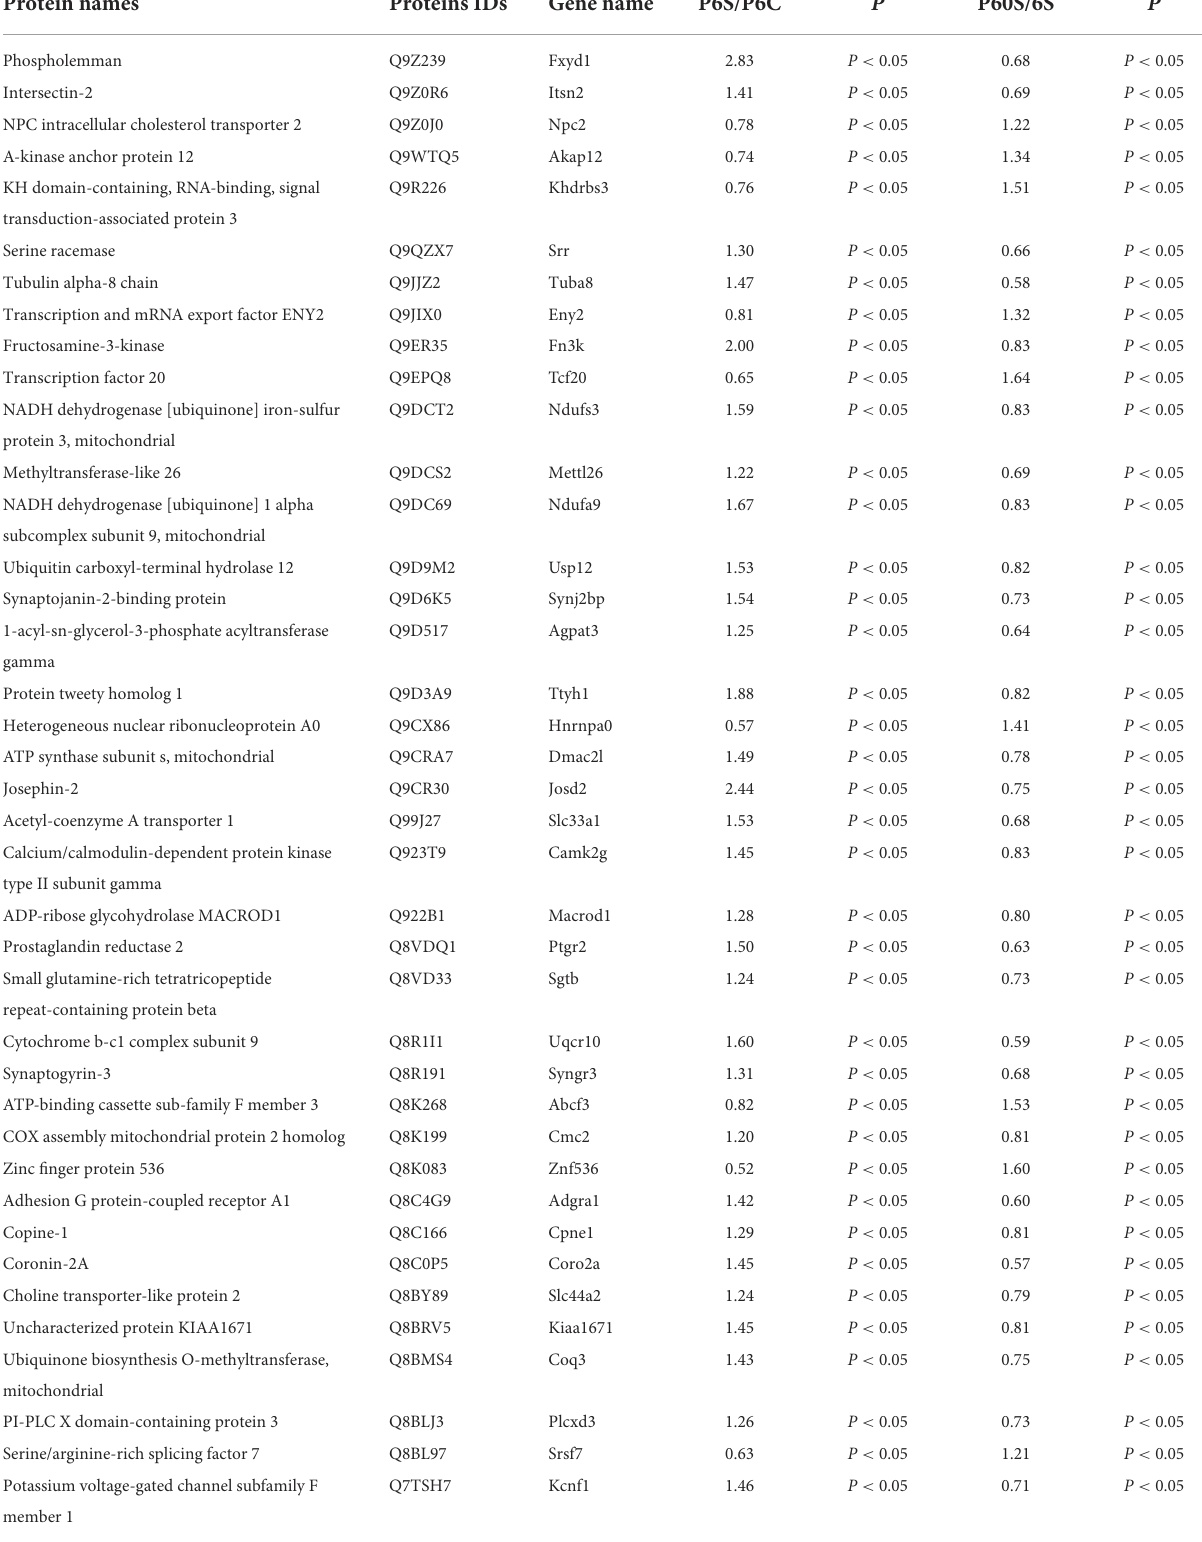
TABLE 1 List of the several sevoflurane-related significantly differential proteins in condition